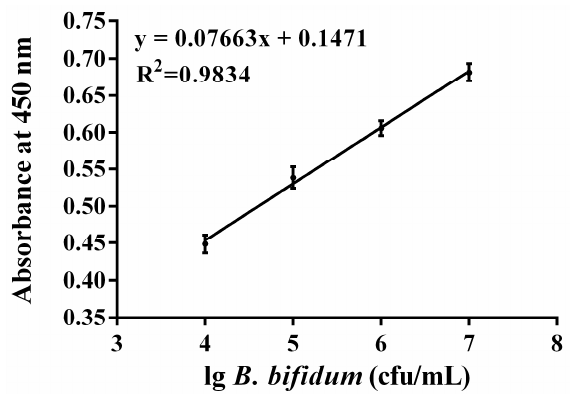
Figure 6. The absorbance at 450 nm measured for different species of bifidobacteria at concentrations ranging from 10 3 to 10 8 cfu/mL. The absorbance at 450 nm represents the mean ± SD of three independent experiments.